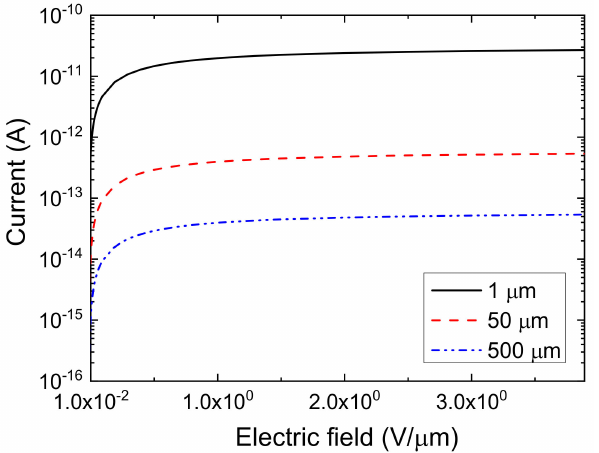
Figure 10. Induced current calculated versus E using Equation (20) for different thicknesses of the diamond layer. The calculation refers to room temperature and the current generated by one